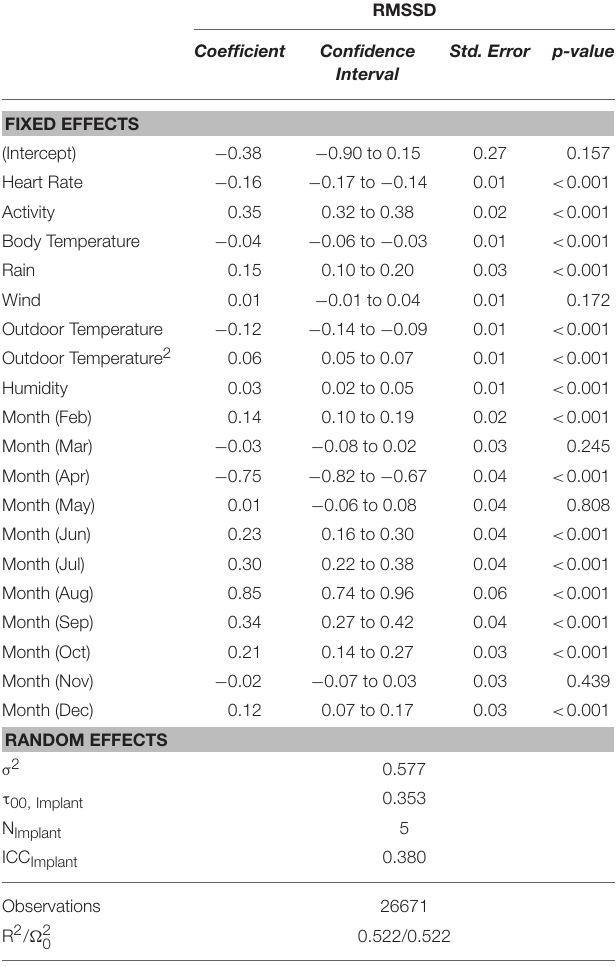
The table provides the fixed and random effects for our final model. Activity, Rain, and Wind are coded as binary variables (i.e., “present” or “not present”). Heart Rate, Body Temperature, Humidity, and Outdoor Temperature are standardized and normally distributed. Our dependent variable is RMSSD, which we log-transformed to account for its highly skewed